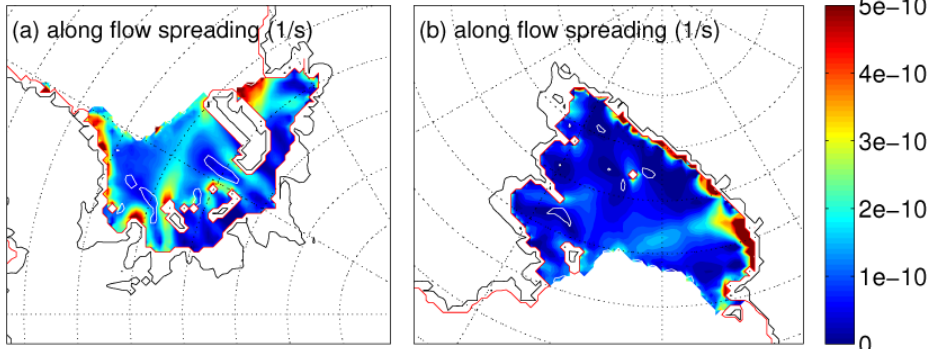
Fig. 5. Calving law applied to (a) Ronne-Filchner and (b) Ross Ice Shelves. Blue shading represents the spreading rate ˙ (cid:15) + along the main flow direction, white lines (zero line of ˙ (cid:15) − ) illustrate possibly weak shelf regions where transversal spreading occurs. (Grounding line is represented by red line, onset of streams by black lines.)